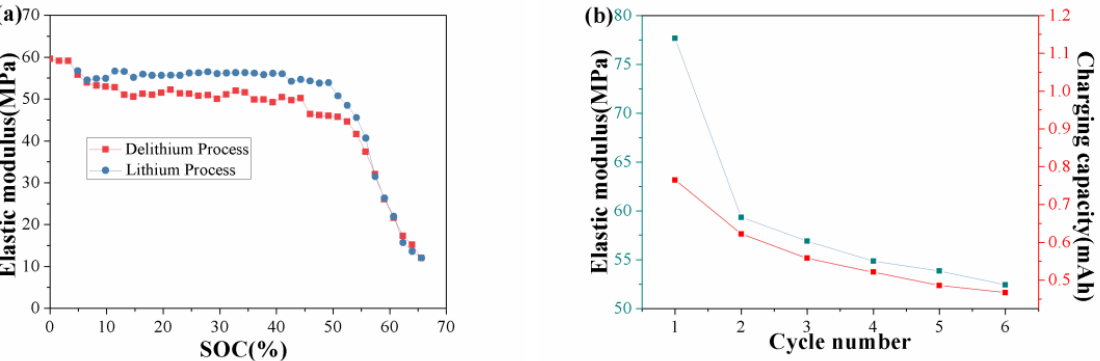
Figure 6. Elastic modulus evolution of LiMn 2 O 4 composite electrodes with time in the ( a ) delithia- tion/lithiation process of the 3rd cycle and ( b ) the end of the lithiation process in each cycle.